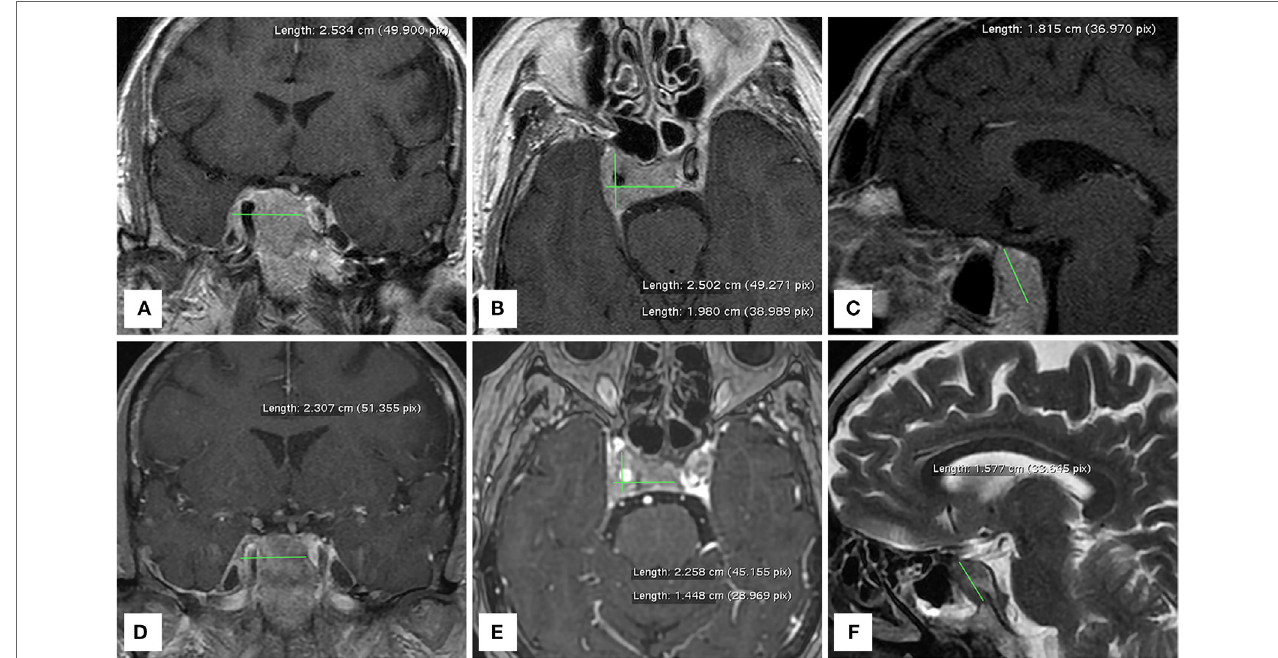
FiGURe 2 | MRI brain scans performed before (a–C) and one month after (D–F) the administration of lenvatinib. The right cavernous sinus metastasis completely encapsulates a consistent portion of the intracranial tract of the right internal carotid artery.